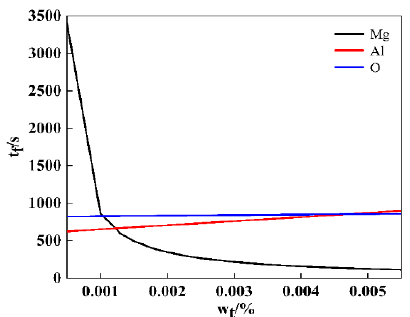
Figure 9. Effect of solute element content in high-carbon hard wire steel on the time of complete modification of Al 2 O 3 inclusions to MgO·Al 2 O 3 .